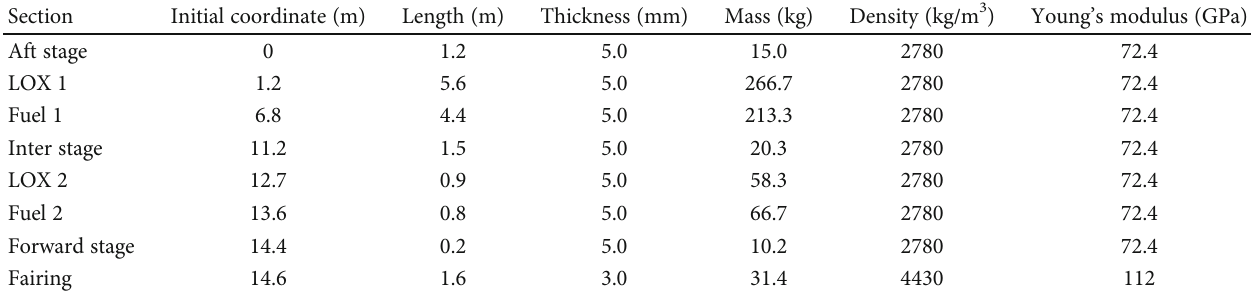
Table 6: Properties of the launch vehicle structural